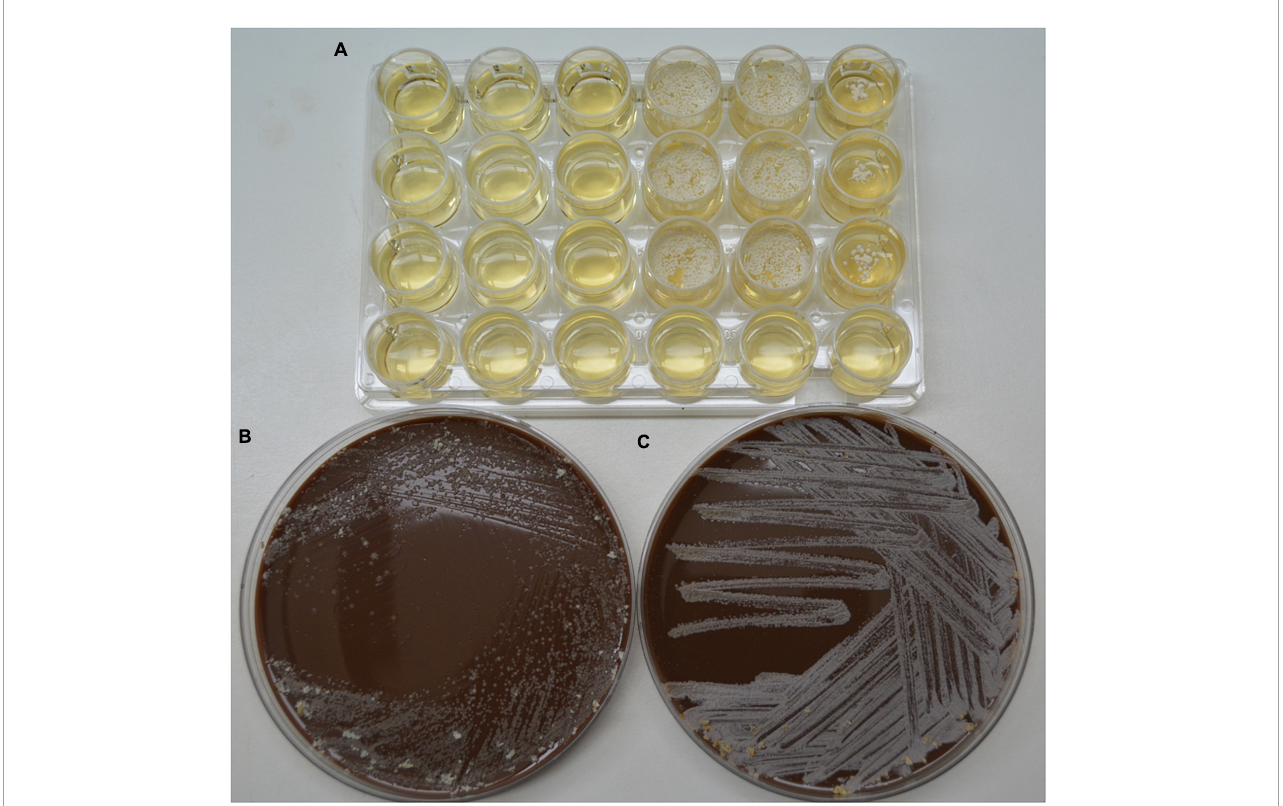
FIGURE12 Comparison of the growth of control strain HUJEG-1 and FM-825 under the effect of β -HFC. (A) 24-well plate with Mueller-Hinton + β -HPC broth; 5 × 10 5 CFU/mL N. brasiliensis HUJEG-1 (ATCC 700358) was seeded in nine wells from the first three columns: 1–3, and rows (A–C) . In column 3 no β -HPC was added, and after 7 days of incubation there was no growth. A total of 5 × 10 5 CFU/mL of N. brasiliensis FM-825 was seeded in columns 4–6 and rows (A–C) . Column 6 was not added with β -HPC. Growth was observed in the seeded wells, and those without β -HPC had little growth. Row D was used as a sterility control of the procedure. (B) Chocolate agar plate, 5 × 10 5 CFU/ml of N. brasiliensis HUJEG-1 (ATCC 700358) were seeded after thawing, grown in M-H with β -HPC and standardized with the McFarland Nephelometer; in all areas of striation, little growth is observed. (C) Chocolate agar plate, 5 × 10 5 CFU/mL of N. brasiliensis FM-825 were seeded after thawing, grown on M-H agar with β -HPC and standardized with the McFarland Nephelometer; abundant growth is observed in all areas of